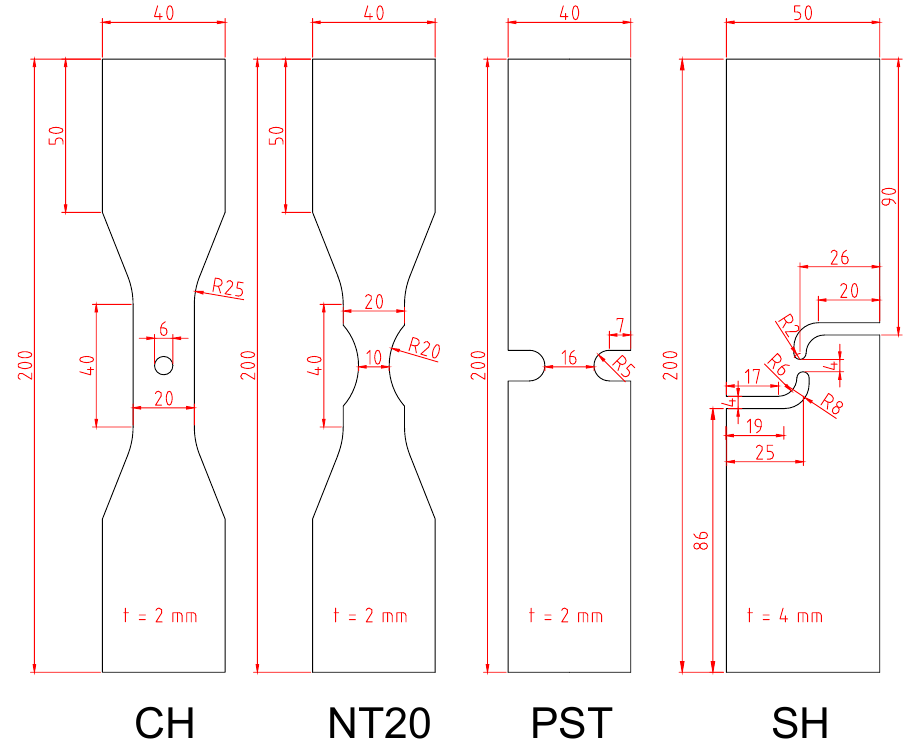
Figure 9. Test specimen geometries (dimensions in